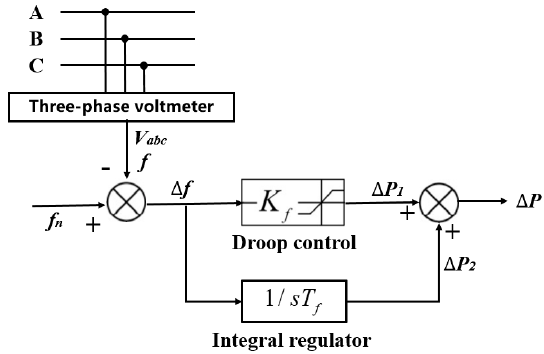
Figure 12. The control block diagram of the hierarchical secondary control method.